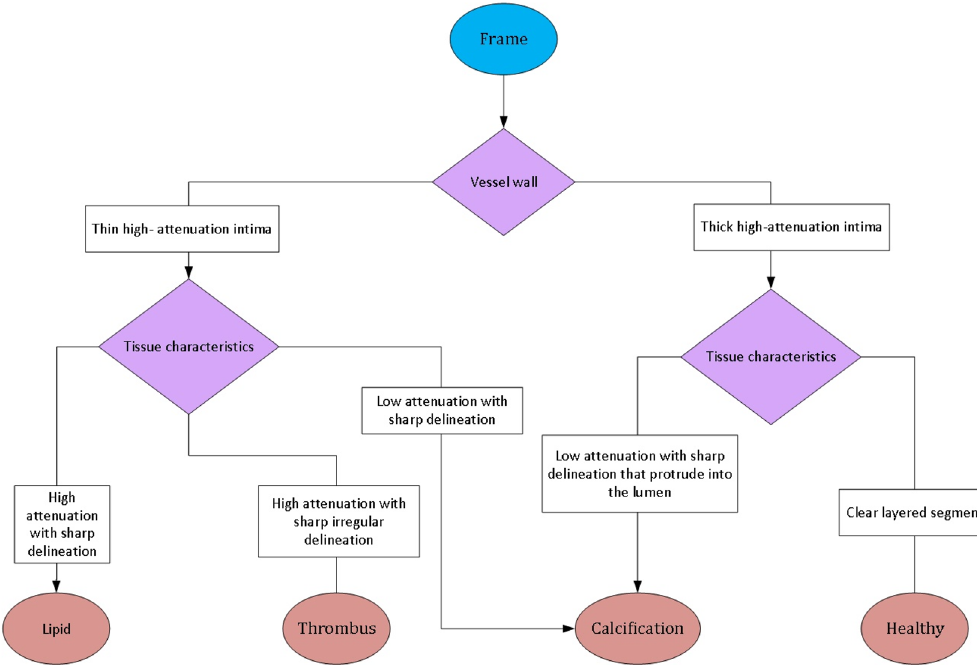
Figure 1. Identification of calcified segments flow chart. (Region of interest—vessel wall characteristics, symmetricity, irregularities